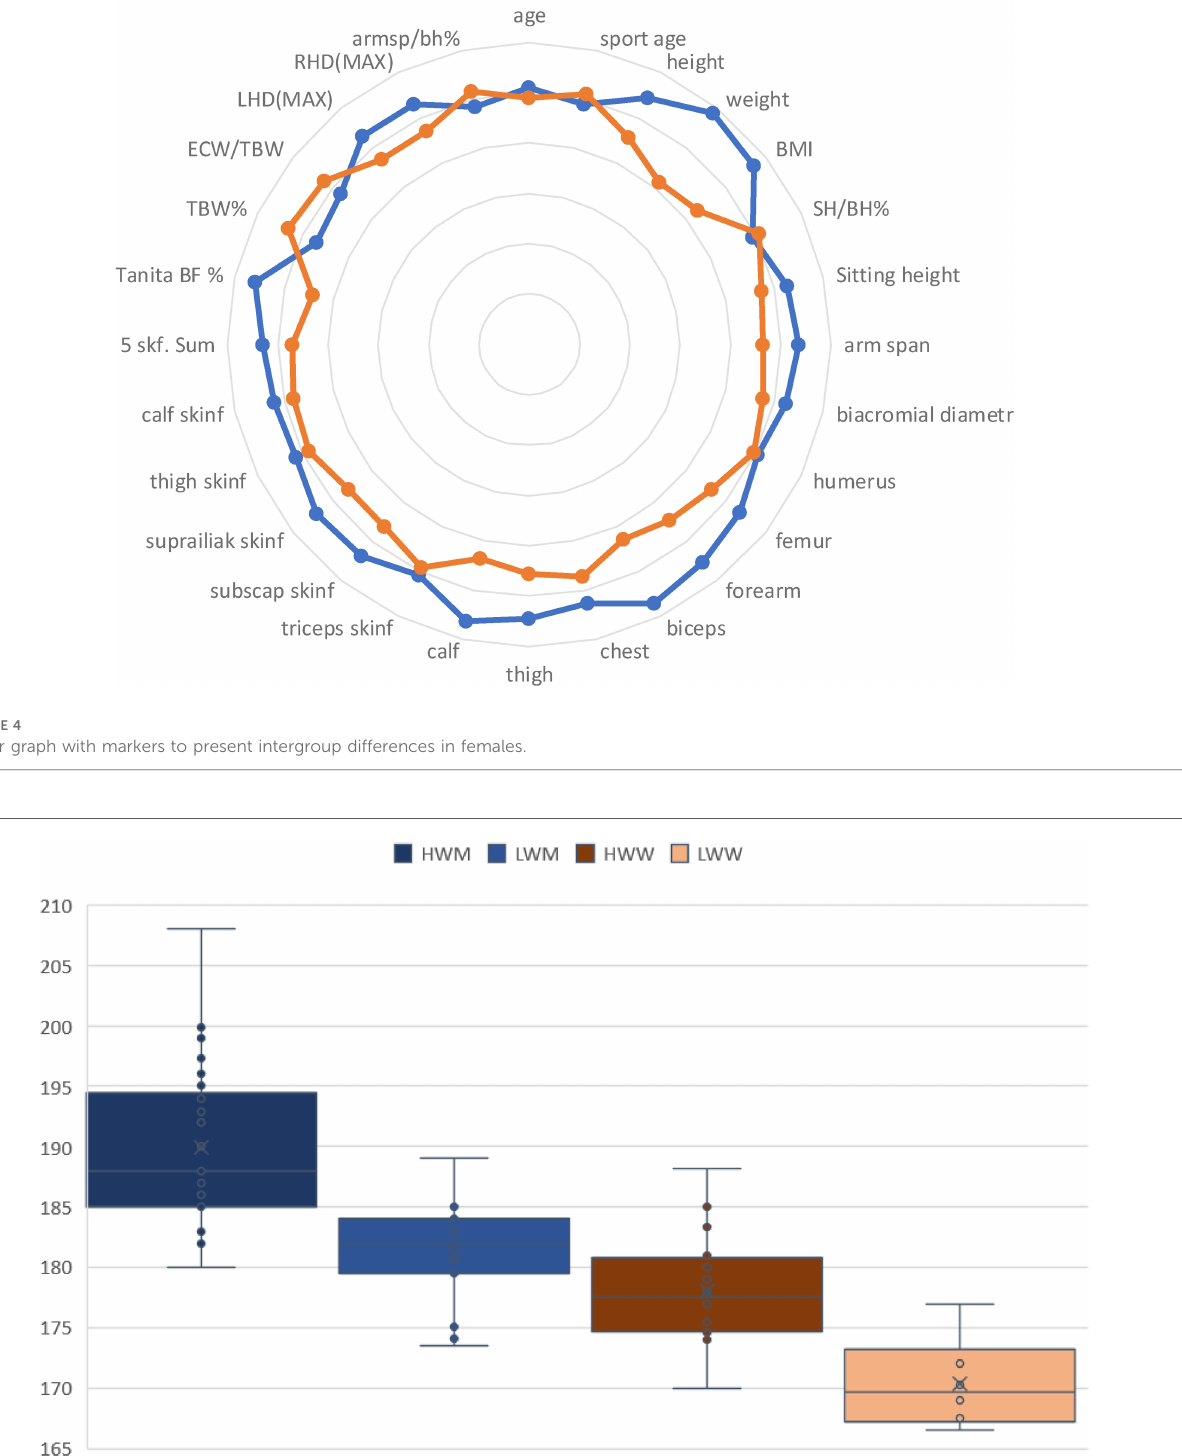
were tall (187.4 ± 5.8 cm) and heavy (82.2 ± 7.4 kg), with larger length, breadth, and girth dimensions than the reference population of boys of the same chronological age (3). Bourgois et al. (3) found